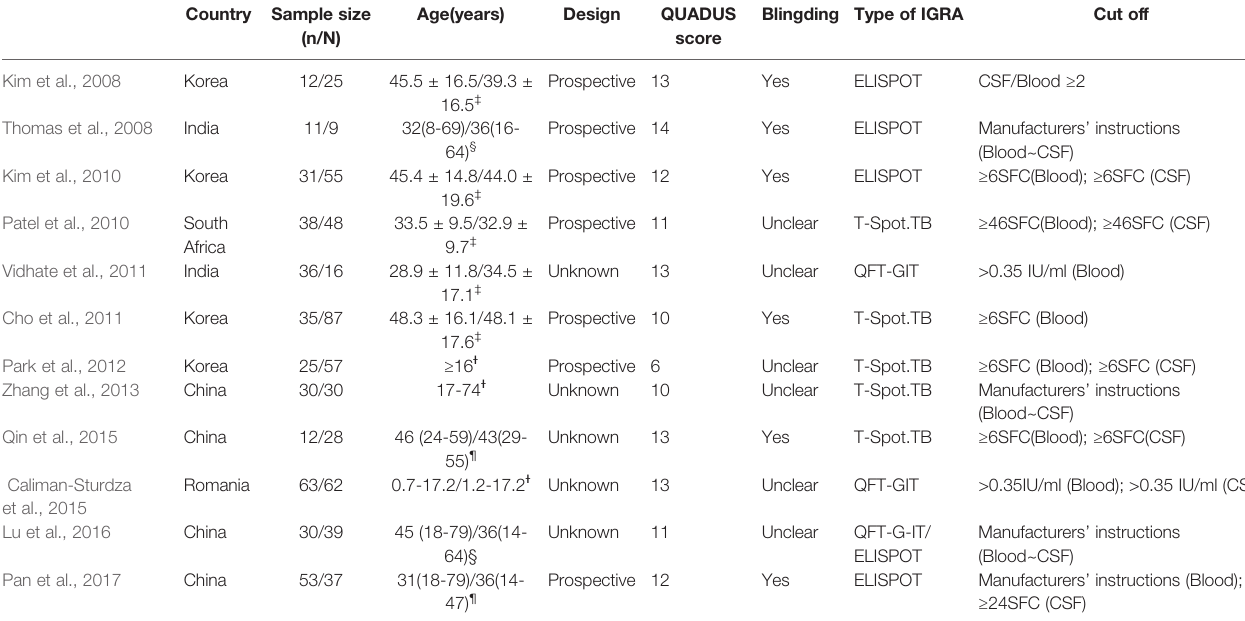
TABLE 1 | Characteristics of the included studies. Country Sample size